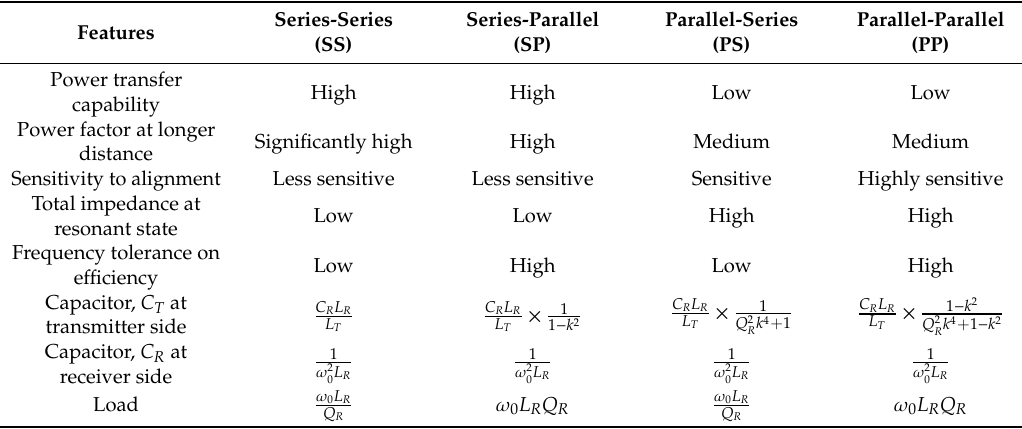
Figure 8. Pad structure according to the core type: ( a ) without (W / O) core, ( b ) circular core, ( c ), slotted core, ( d ) bar core, ( e ) circular bar core, and ( f ) divided circular core. Table 5. Characteristics of compensation